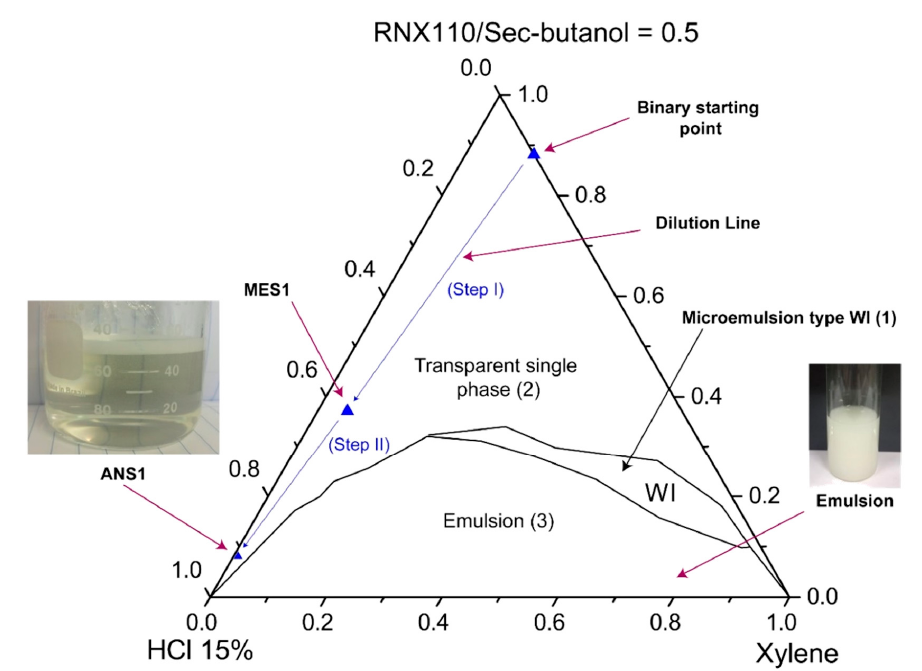
Figure 7. Phase diagrams for systems with RNX110.